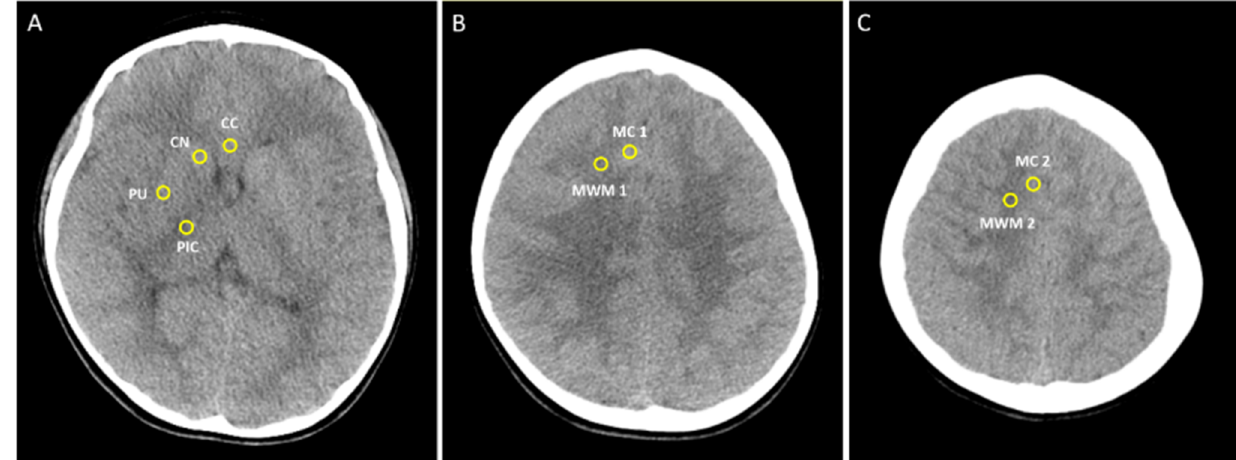
Figure 1. The points of measurement in Hounsfield units of brain computed tomography at A) Basal ganglia level, B) Centrum semiovale level, C) High convexity level. ( A ) Regions of interest (ROI) (10mm2) are positioned in 5 points of the genu of the corpus callosum (CC) (1), caudate nucleus (CN) (2), putamen (PU) (3), posterior lime of internal capsule (PIC) (4). ( B , C ) ROI are positioned in 2 points of the medial cortex (MC 1 and MC 2) and medial white matter (MWM 1 and MWM 2). Grey and White matter ratio (GWR) in basal ganglia was calculated as follows: (CN + PU)/(CC + PIC). GWR in medial cortex and white matter was calculated as follows: (MC1 + MC2)/(MWM1 + MWM2). Average GWR was defined as the average of these 2 GWR (GWR of basal ganglia + GWR of cerebrum/2).